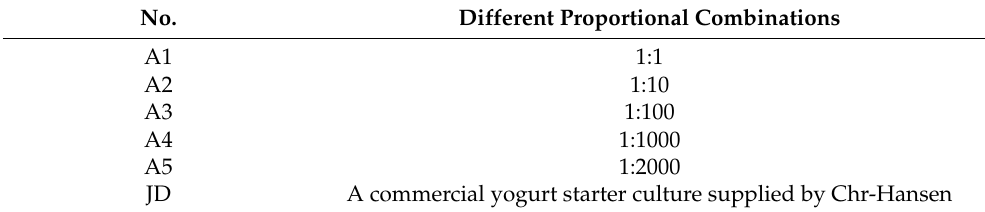
Table 5. Five ratios of L. delbrueckii subsp. bulgaricus IMAU20312 and S. thermophilus IMAU80809 that were used as mixed starter cultures in this study.